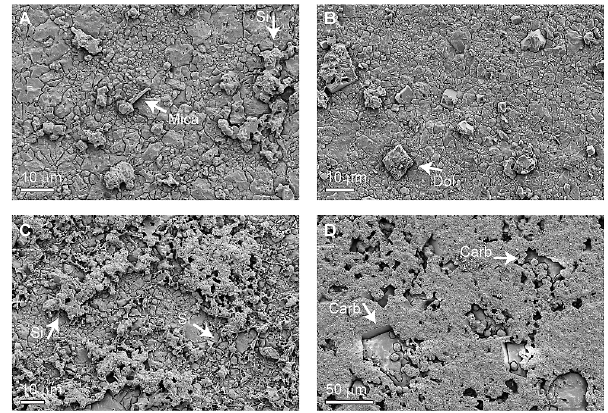
Fig. 4. Examples of diagenetic alteration of micrite and mi- crosparite. (A) Slightly silicified sample with minor terrigenous component (mica crystal in the center of the frame). Calcareous nannofossils are easily visible. Silicified patches (Si) stick out of the sample plain because of etching. Pignola-Abriola section, Parvigon- dolella andrusovi–Misikella hernsteini conodont zone, late No- rian, 33.3m in Fig. 3. (B) Dolomite rhombohedrons (Dol) in mi- crosparitic lime mudstone. Pignola-Abriola section, Misikella ul- tima conodont zone, Rhaetian, 58.8m in Fig. 3. (C) Silicified lime mudstone. Silica (Si) occupies a large part of the rock volume in this frame, and can be found in interstitial position between car- bonate crystals or as patches. Pignola-Abriola section, Parvigon- dolella andrusovi–Misikella hernsteini conodont zone, late No- rian, 40.7m in Fig. 3. (D) Strongly silicified sample. Carbonate (Carb) is only present as a few crystals that partially engulf sil- ica with spheroidal shape (chalcedony?). Locally, carbonate crys- tal faces are instead preserved. Pignola-Abriola section, Parvigon- dolella andrusovi–Misikella hernsteini conodont zone, late Norian, 45.1m in Fig.